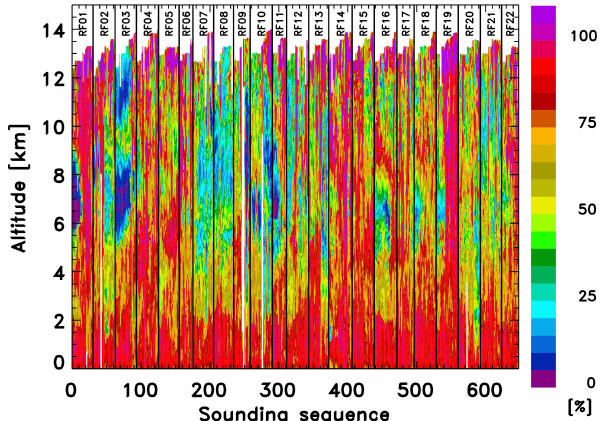
Figure 10. Color contours for all relative humidity measurements. Note that at temperatures below freezing, relative humidity is shown with respect to ice. Vertical lines separate the research flights, which are indicated in each group.